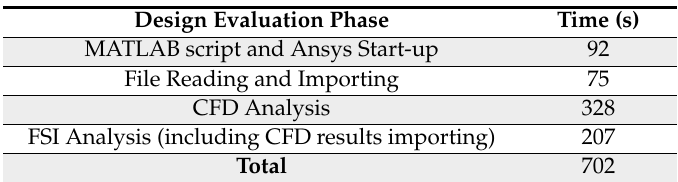
Figure 8. Overview of finite element analysis (FEA) boundary conditions applied of stator (left) and rotor (right). Table 3. Design evaluation